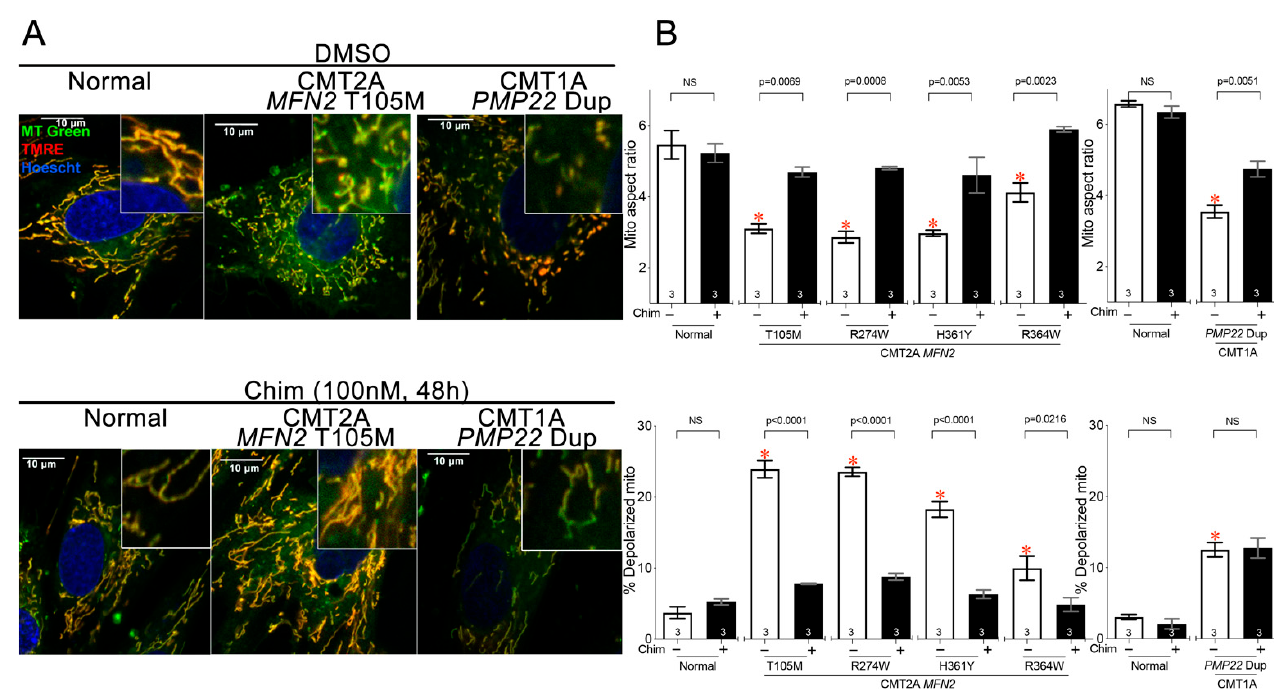
Figure 3. Mitofusin activation improves mitochondrial dysmorphology and dysfunction in CMT2A and CMT1A patient dermal fibroblasts. ( A ) Representative confocal images of normal, CMT2A (MFN2 T105M mutation), and CMT1A (PMP22 Dup) patient fibroblasts cultured in galactose medium; Mito Tracker Green (green), TMRE (red), Hoechst (blue). Insets show further magnified images for clarity. Healthy mitochondria are yellow/orange; depolarized mitochondria are green. Scale bars are 10 microns. ( B ) Quantitative group data for mitochondrial aspect ratio (above) and depolarization (below) from two normal patients, four CMT2A patients with different MFN2 mutations, and one CMT1A patient with PMP22 duplication. Note that the MFN2 R364W mutation causes a less severe mitochondrial phenotype. White bars indicate vehicle-treated cells and black bars indicate treatment with 100 nM Chimera for 48 h. Data are means ± SEM; p values from two-way ANOVA; * = p < 0.05 vs. DMSO-treated normal fibroblasts; individual p values are given for Chimera vs. vehicle within each genotype. NS = Nonsignificant. The number of independent experiments is shown on the bottom of each bar.